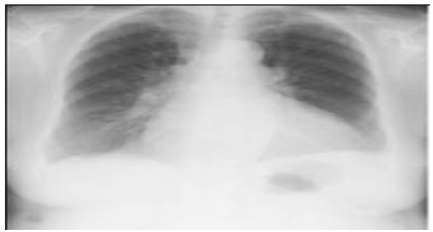
Figure 1: Original image.